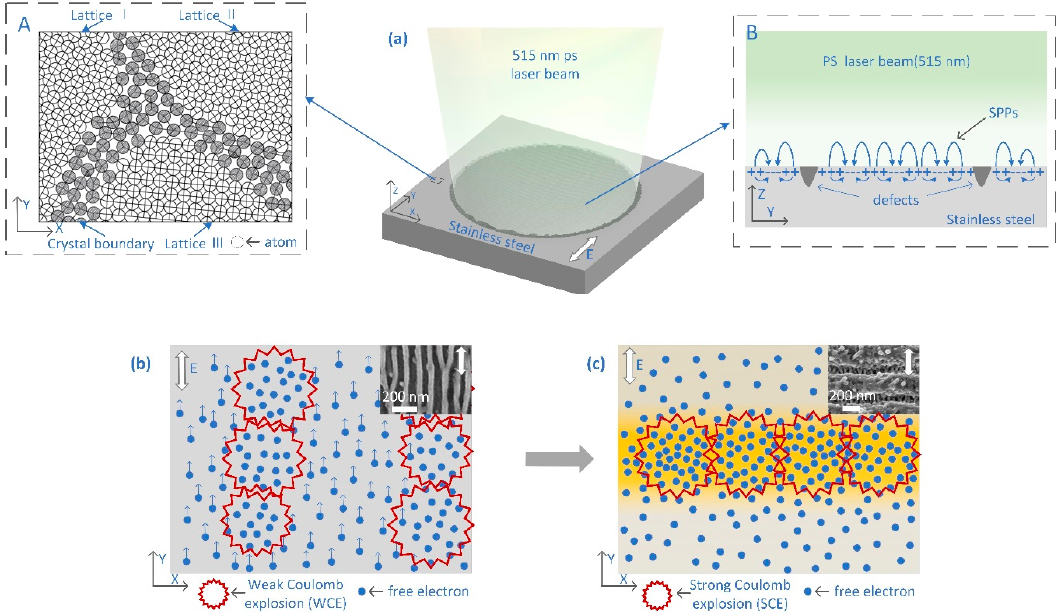
Figure 11. Schematic of the surface plasmon polariton (SPP)-modulated periodic coulomb explosion for the formation mechanism of hierarchical periodic NSRs and DSRs. ( a ) The picosecond laser irradiated on the stainless-steel surface. The dotted frame ( A ) indicated the atomic arrangement of the grains of 304 austenitic stainless steel. The dotted frame ( B ) shows the surface plasmon standing wave field induced at high energy density during laser irradiation. ( b ) The formation of DSRs under the material removal of coulomb explosion. ( c ) The NSRs induced by the periodically modulated by the surface plasmon standing wave.